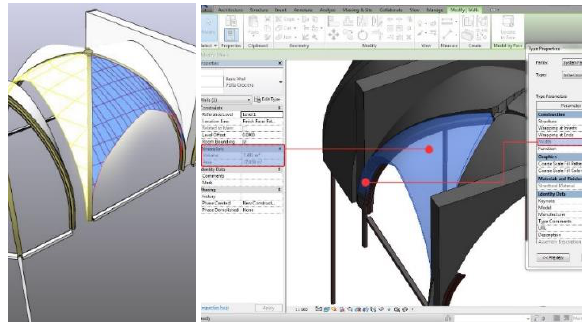
Figure 7. Solid generated with NURBS in ©Rhino and then parameterized in ©Revit.